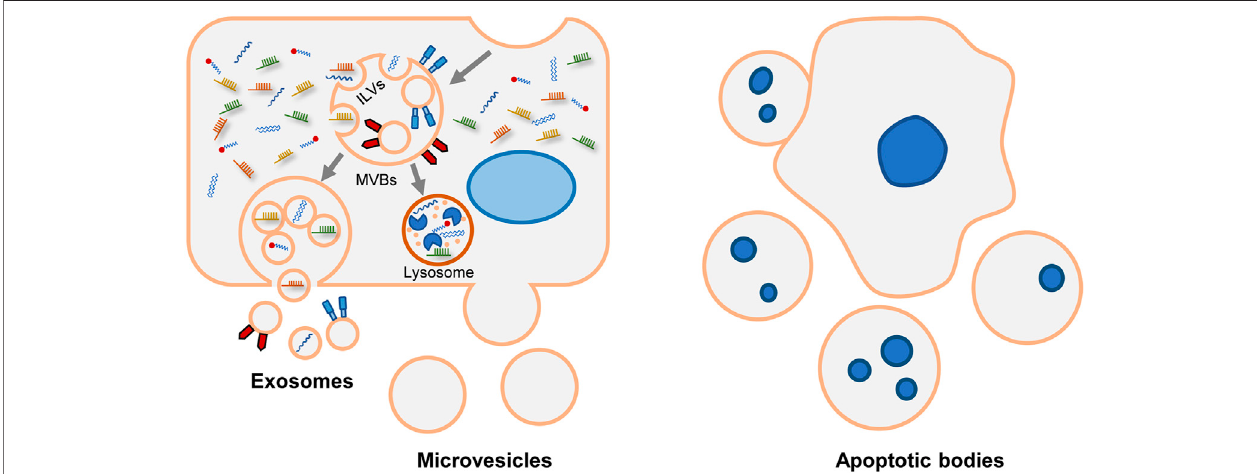
FIGURE1| BiogenesisandreleaseofvariousEVs.Generally,EVsaredividedintoexosomes,microvesiclesandapoptoticbodies.Exosomalformationbeginswith endocytic process. After the endosomal membrane invagination, intraluminal vesicles (ILVs) are formed. The endosomes containing ILVs are referred as multivesicular bodies (MVBs). Subsequently, MVBs have two fates. They can be degraded in lysosomes. Alternatively, MVBs merge with plasma membrane and release ILVs as exosomes. Microvesicles are formed through direct budding process. Apoptotic bodies are formed during